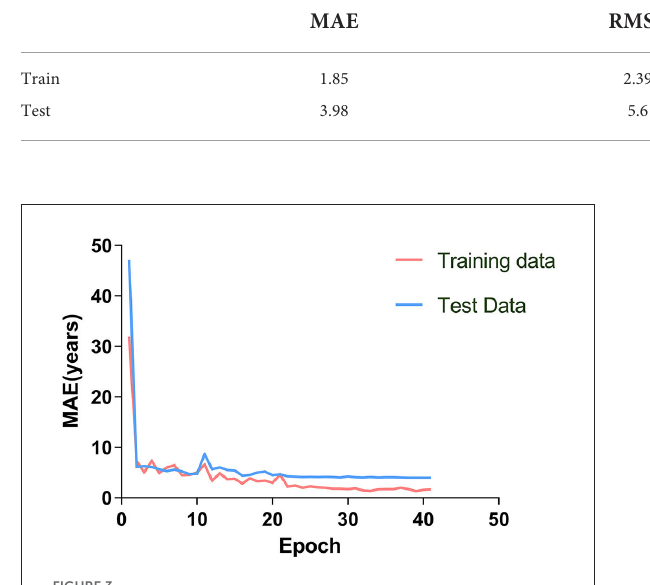
FIGURE3 The brain age prediction model was trained 40 times. The MAE of the training and test sets decreased gradually and tended to be stable with increased training